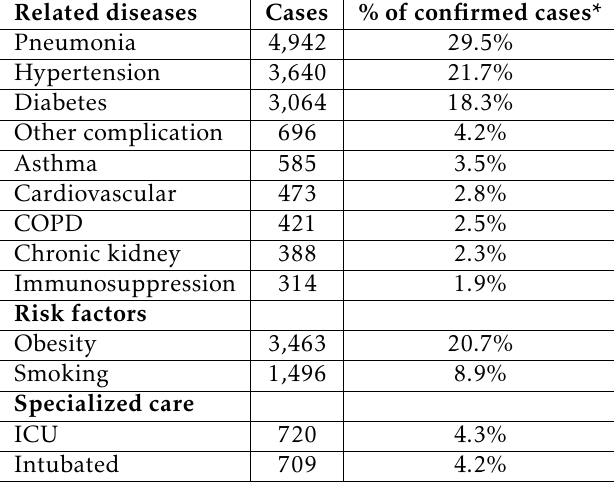
Table 2. Related diseases, risk factor and specialized care of